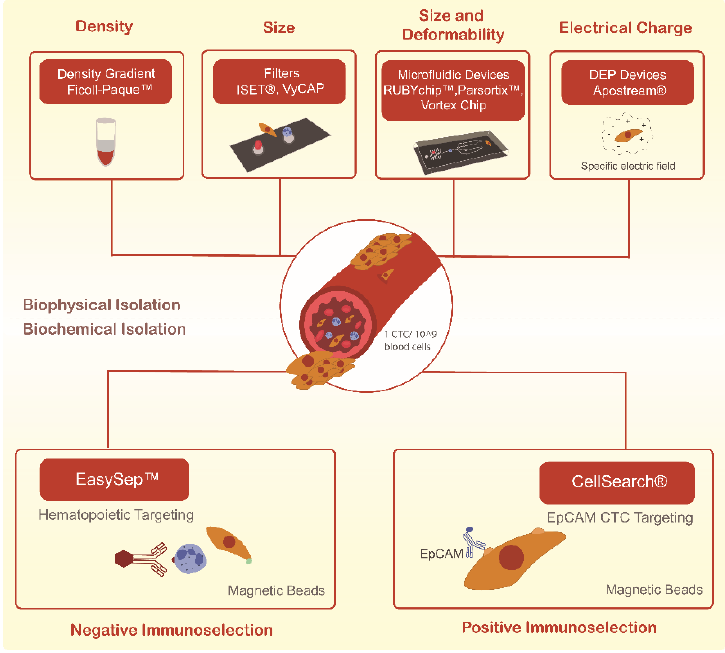
Figure 1. Current methodologies used to isolate circulating tumor cells (CTCs) through biological and biophysical properties.